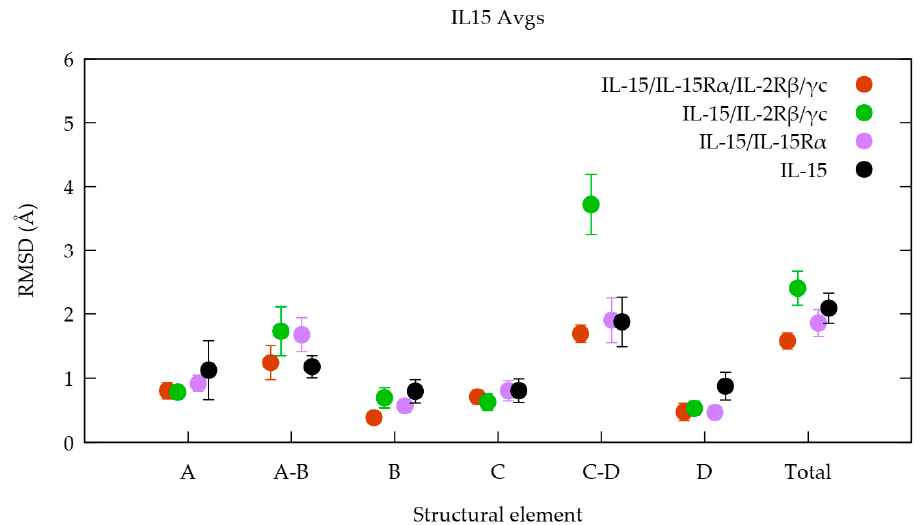
Figure 3. Average RMSDs values together with their standard deviations, calculated for each specific structural elements of the IL-15 chain over the last 100 ns of the MD simulations.